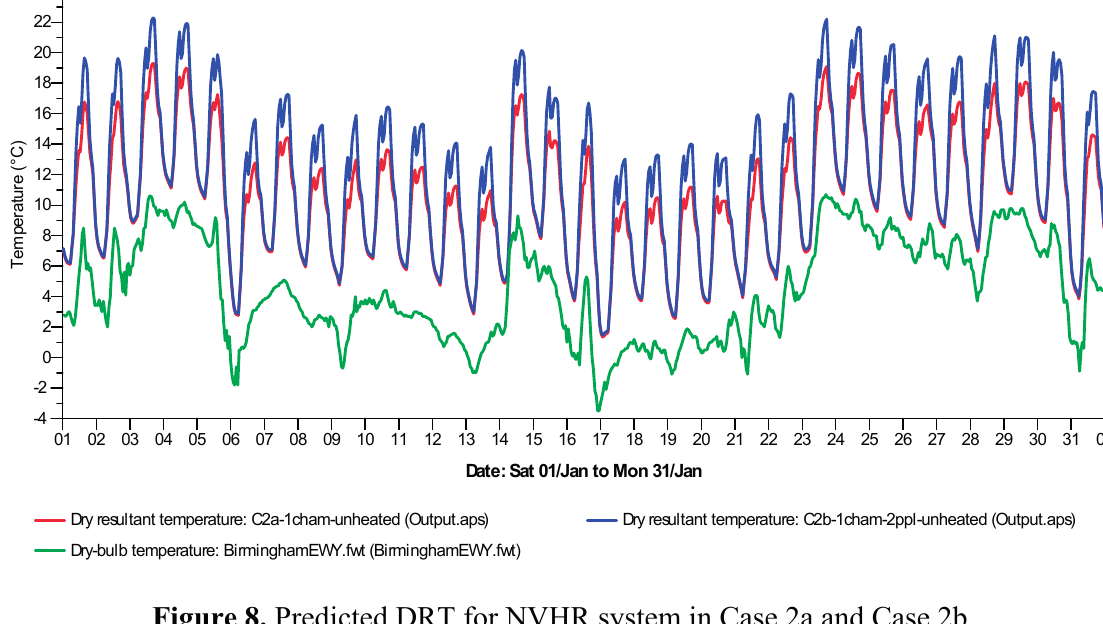
Figure 8. Predicted DRT for NVHR system in Case 2a and Case 2b.